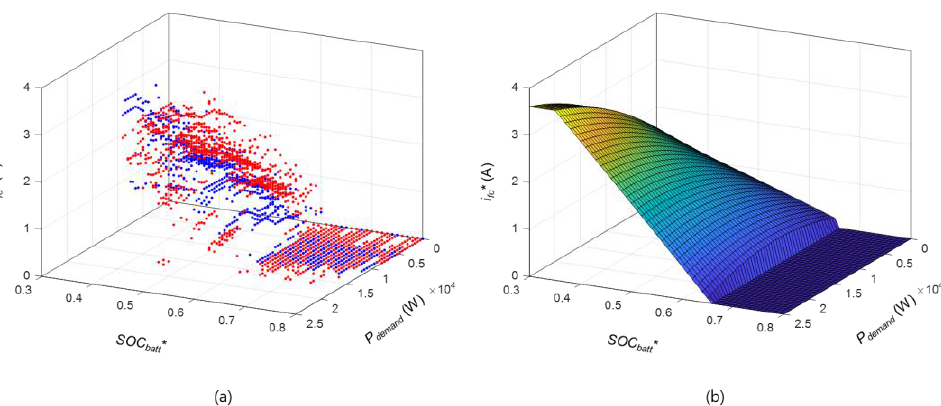
Figure 6. Allowable current of the fuel cell system for an optimal energy management control strat- egy: ( a ) Maximum i fc * with respect to the given P demand and the SOC batt *(Blue color represents the NEDC cycle and red color represents the WLTC cycle); ( b ) Allowable i fc *.